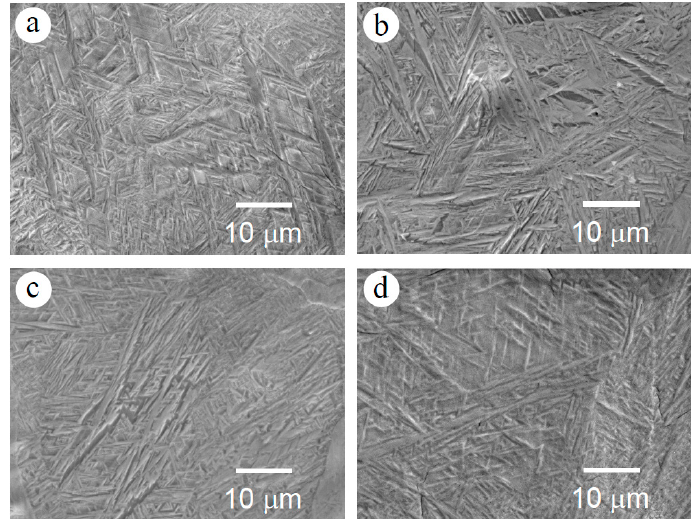
Figure 8. SEM images of the as-built Zr-1Mo alloys with various energy densities: ( a ) 35.2 J·mm − 3 ,